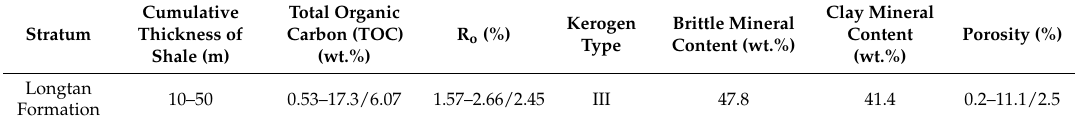
Kerogen Brittle Mineral R o (%) Type Content (wt.%)